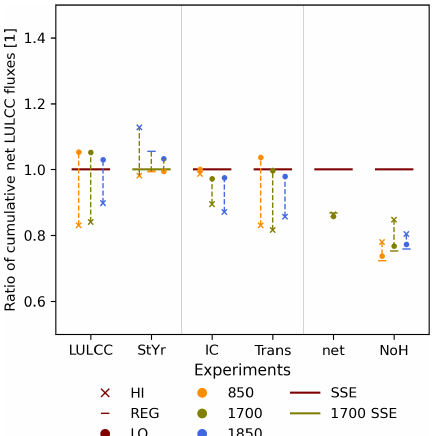
Figure 3. Comparison of global cumulative net LULCC flux be- tween 1850 and 2014 for various simulations, normalised with a respective reference/standard sensitivity experiment (SSE, see also Table 2): REG tt for LULCC (first column), xx 1700 for start year (second column), REG tt for IC and Trans experiments (third to fourth columns), and xxtt for net and NoH experiments (fifth and sixth columns). Here, tt ( xx ) means that the reference year (land-use scenario) varies for each experiment in the respective column. Ref- erence examples are REG1850 for HI1850 in the LULCC compari- son, REG1700 for REG1850 in the StYr comparison and LO850 for LO850NoH in the NoH comparison. The colour of the connecting lines represents the reference